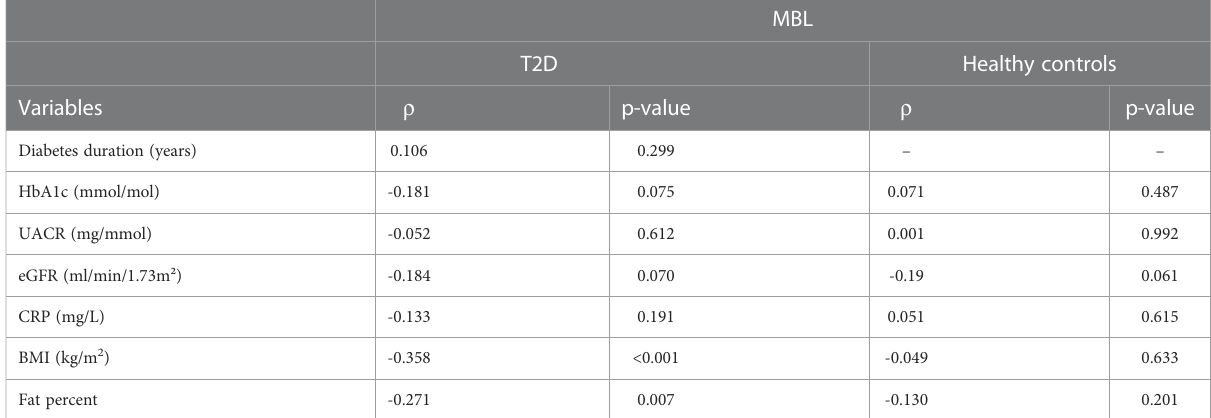
TABLE 3 An overview of Spearman ’ s correlation analysis (r) and p-value for serum MBL levels and different variables according to diabetes